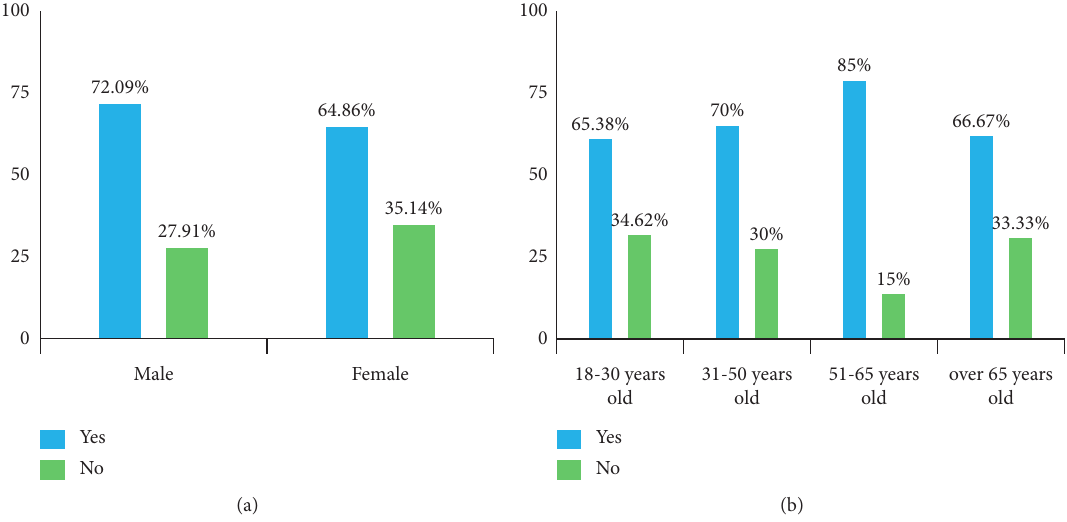
Figure 2: Breakdown of choice behavior according to sex and age.